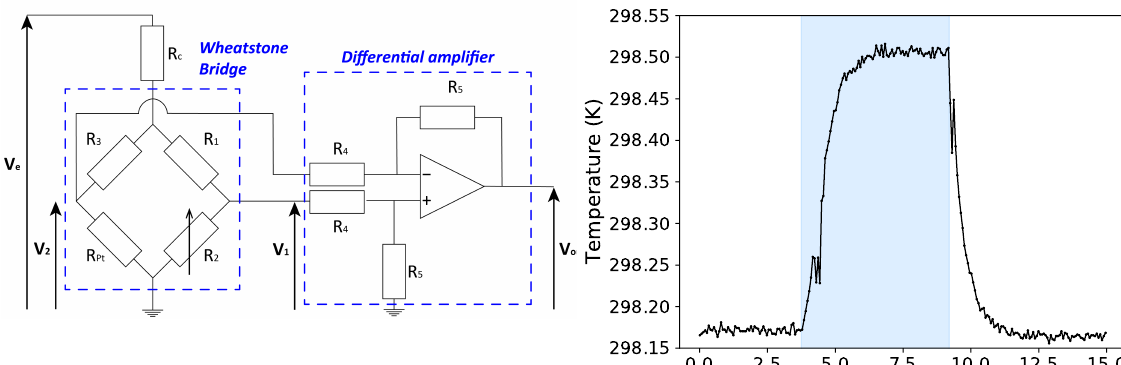
Figure 4: Measurement of the resistance of a Pt resis- tive thermometer with a Wheatstone bridge and ampli- fied by an opamp-based circuit.